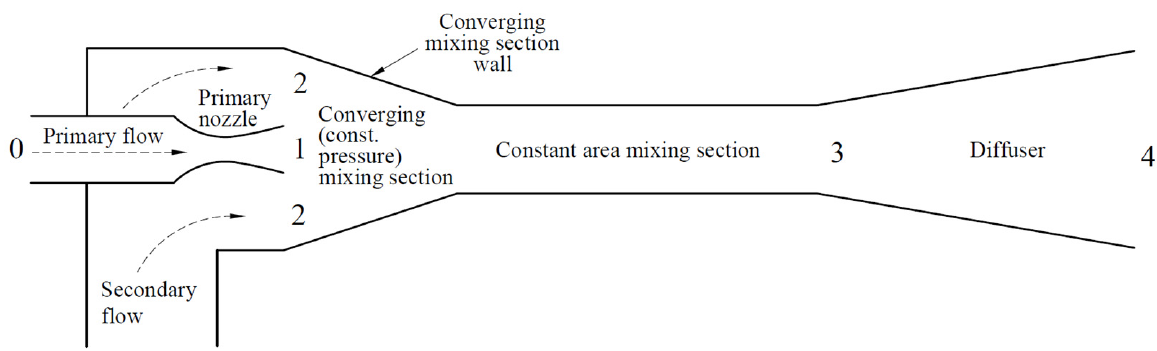
Figure 1. Schematic of a typical ejector.